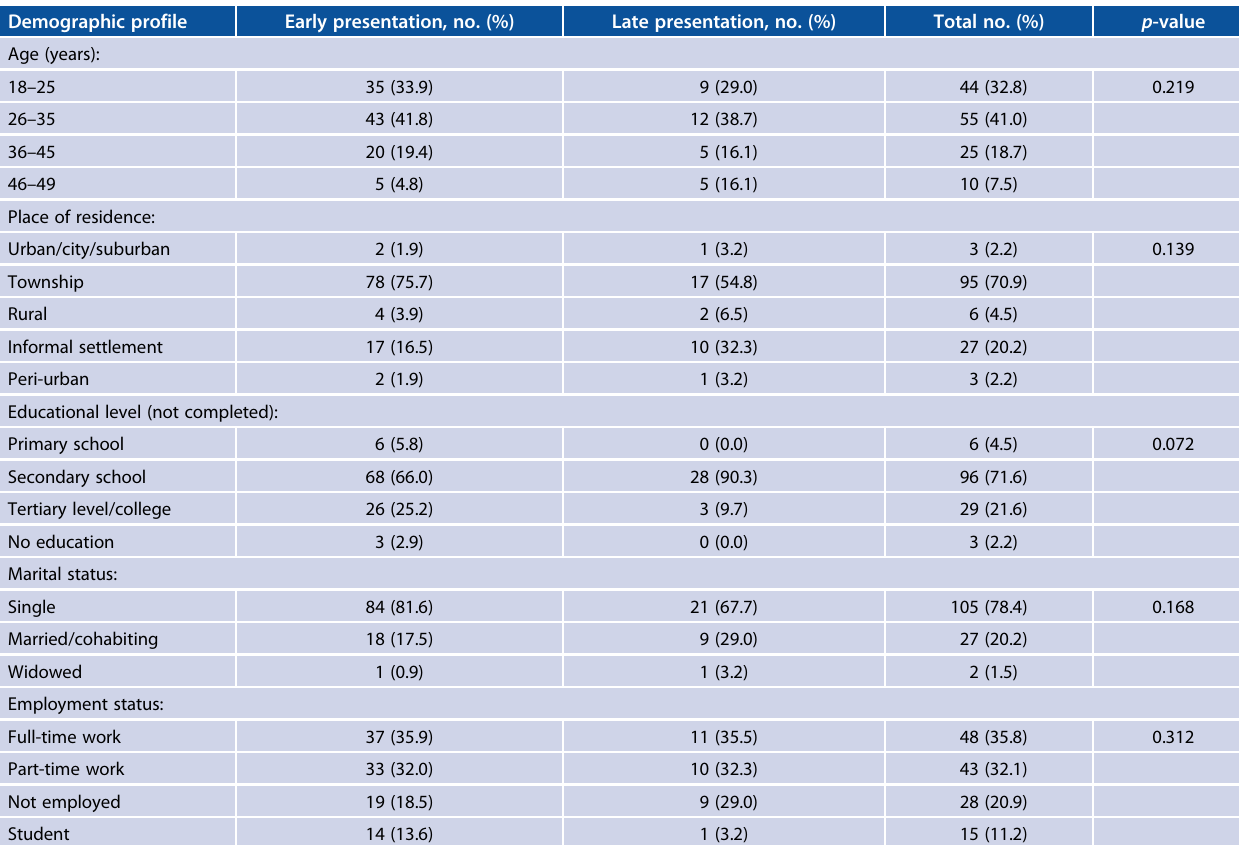
Table 1: Sociodemographic profile of participants showing the proportions in the early presentation ( n = 103; 76.9%) vs. late presentation ( n = 31; 23.1%) groups (number, %) Demographic